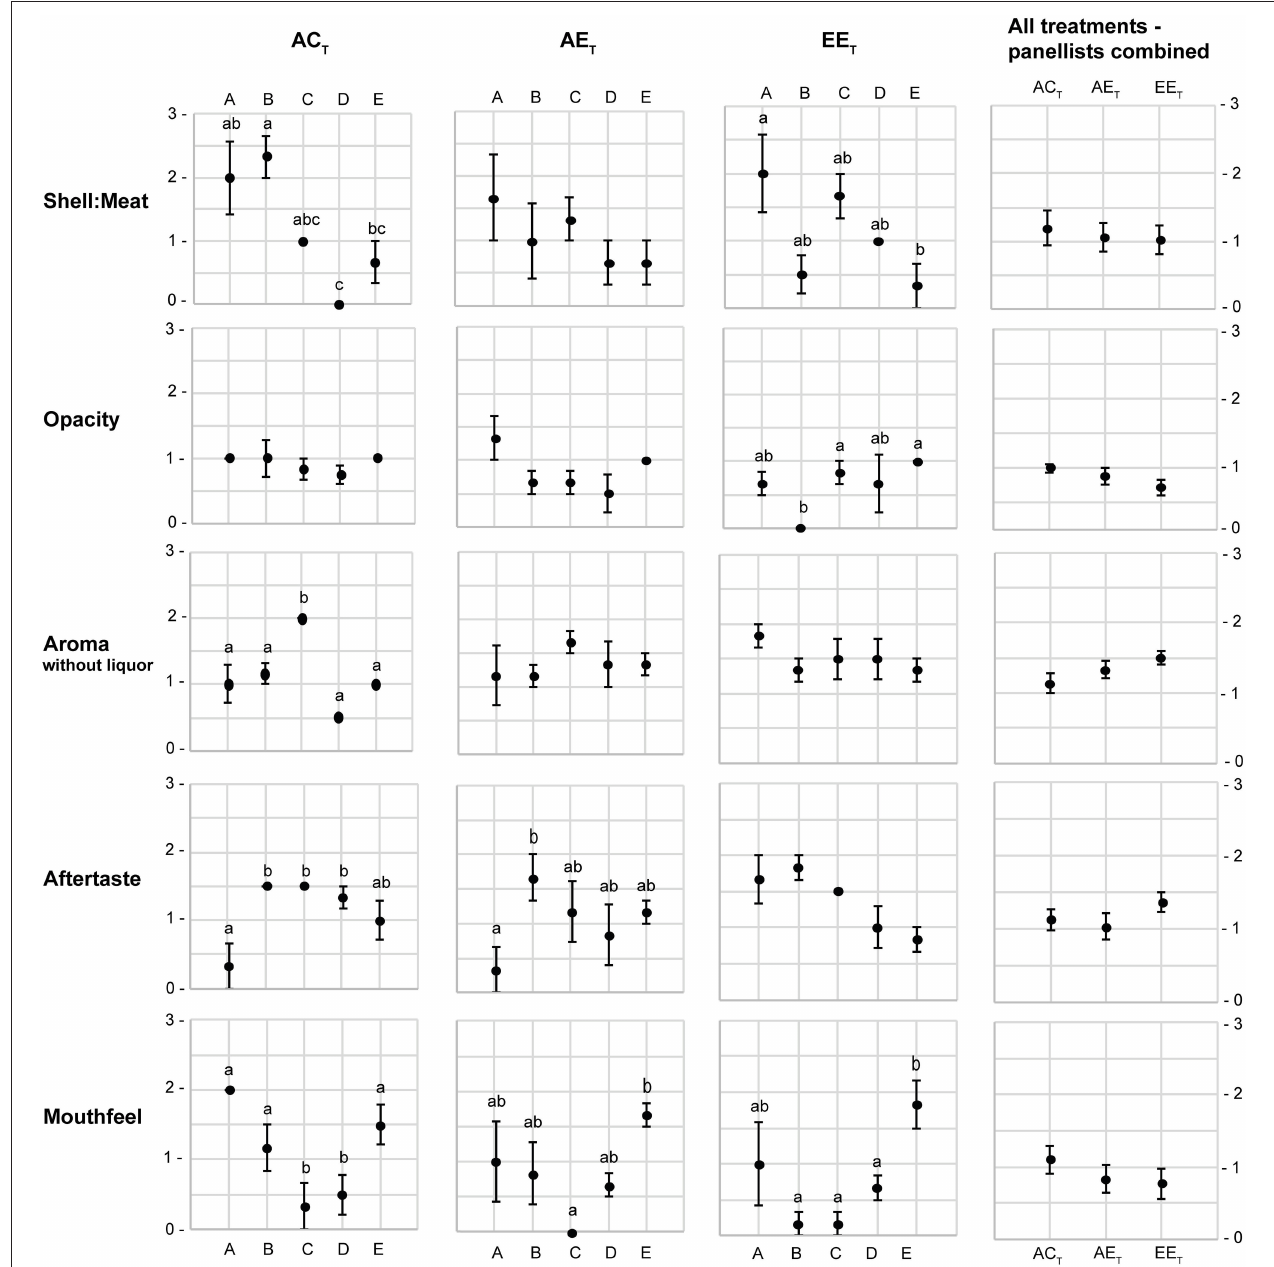
FIGURE 4 | Mean score ( ± S.E.) of the attributes that displayed significant interaction between “panelist” and “treatment”. Letters A–E represent the five panelists. AC T , ambient p CO 2 and control temperature; AE T , ambient p CO 2 and control temperature; EE T, elevated p CO 2 and elevated temperature. All attribute scores ranged from 0 to 3 (0 representing the optimum score, and 3 the least favorable score). Treatment levels that do not share a letter are significantly different.